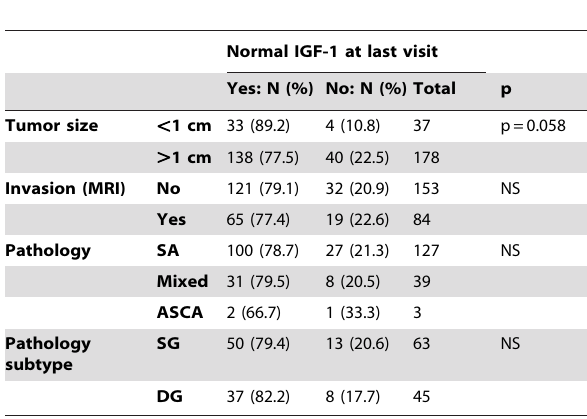
Table 3. IGF-1 normalization according to pituitary tumor